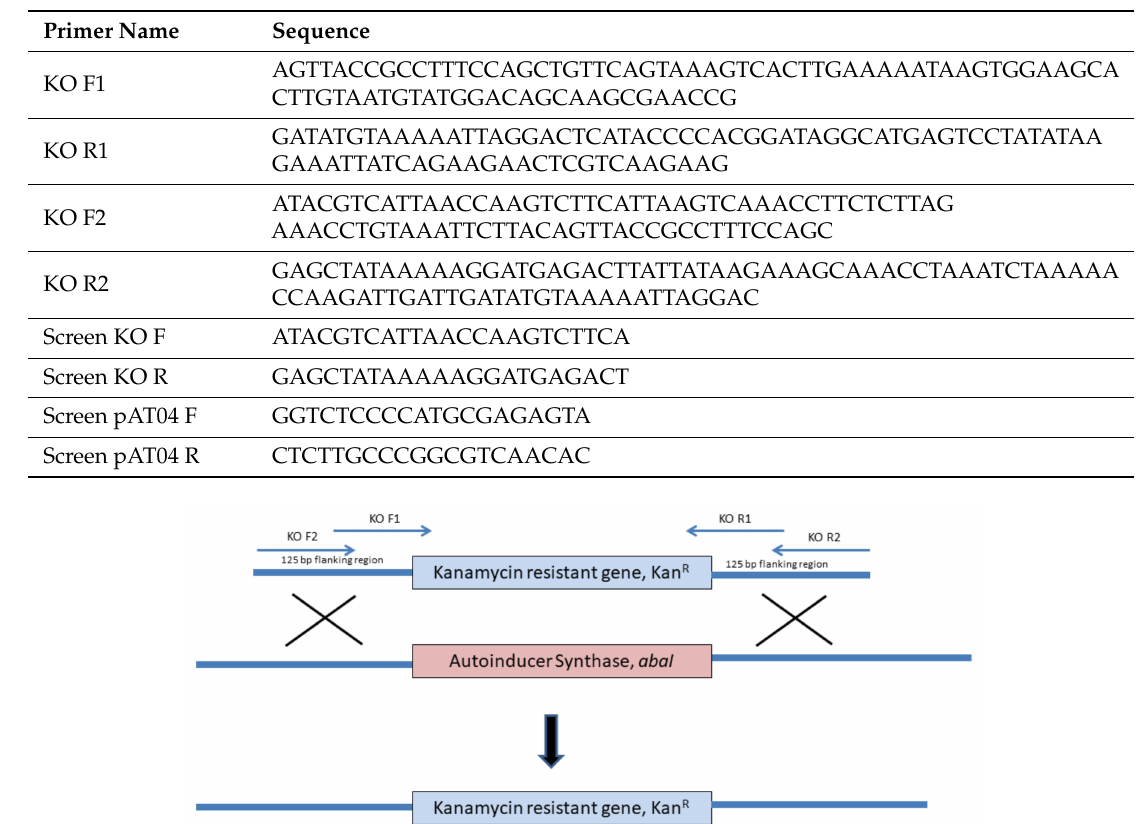
Table 2. Primers used in KO cassette construction.